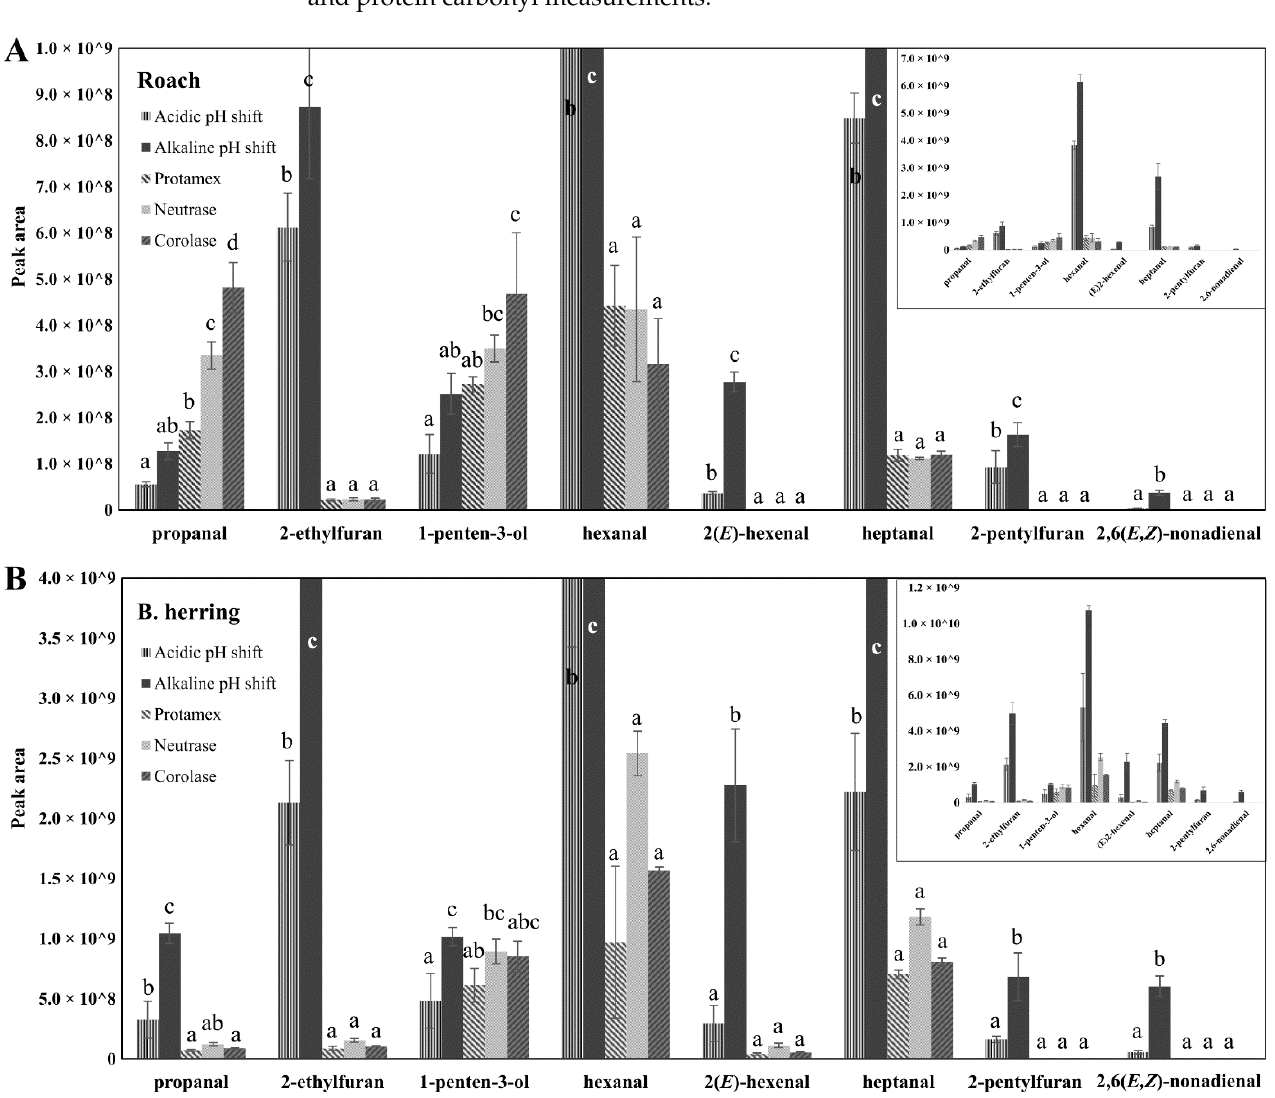
Figure 4. Peak areas of seven oxidation related volatiles, analyzed using headspace solid-phase microextraction-gas chromatography-mass spectrometry, in protein isolates from roach ( A ) and B. herring ( B ). Different letters indicate a statistically significant difference ( p < 0.05) between sam-